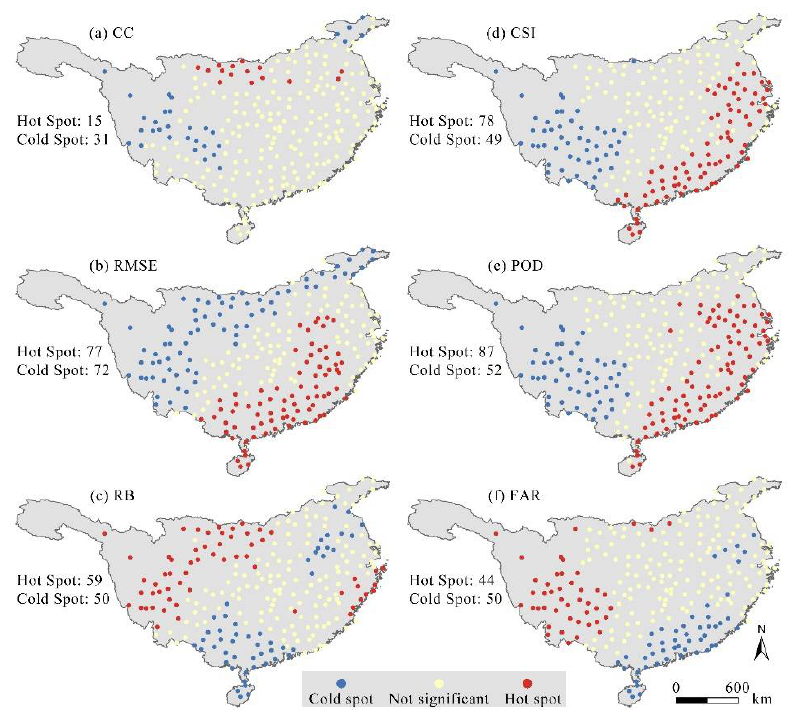
Figure 4. The spatial clustering of statistical indices (( a ) CC, ( b ) RMSE, and ( c ) RB) and categorical indices (( d ) CSI, ( e ) POD, and ( f ) FAR).